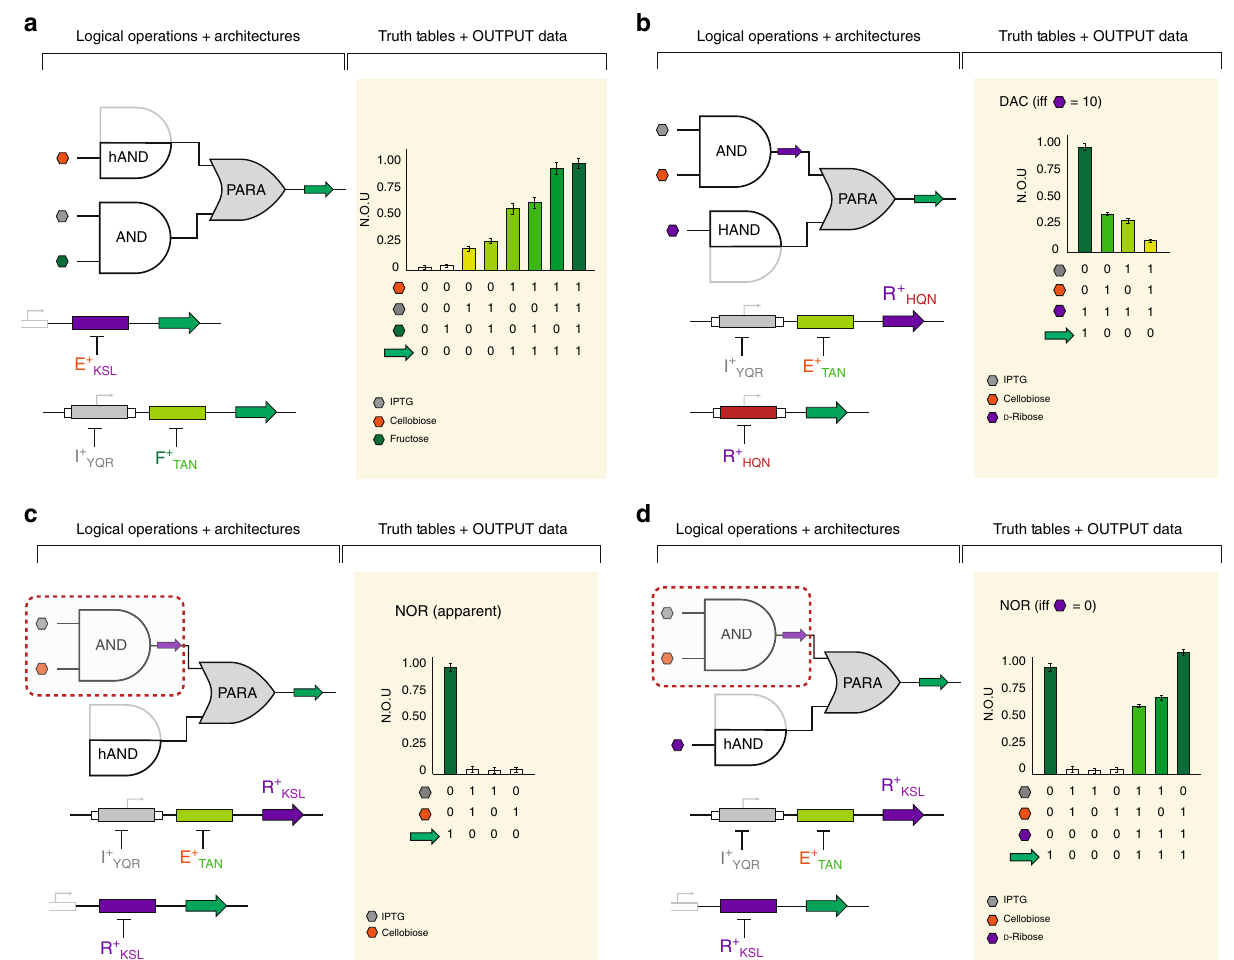
Fig. 7 Digital-to-analog converters (DAC) and NOR gates. Analog behavior is inherent in biological systems and is exploited in the following circuits. a Asymmetric parallel con fi guration composed of three non-synonymous DNA operators. The progressive addition of ligands (which represent digital inputs 0 or 1) leads to a gradual increase in GFP output. b A second asymmetric parallel system (denoted AND [PARA] HAND) where the two channels are coupled via an engineered TF-operator pair. The production of R + HQN is dependent on the addition of IPTG and cellobiose such that